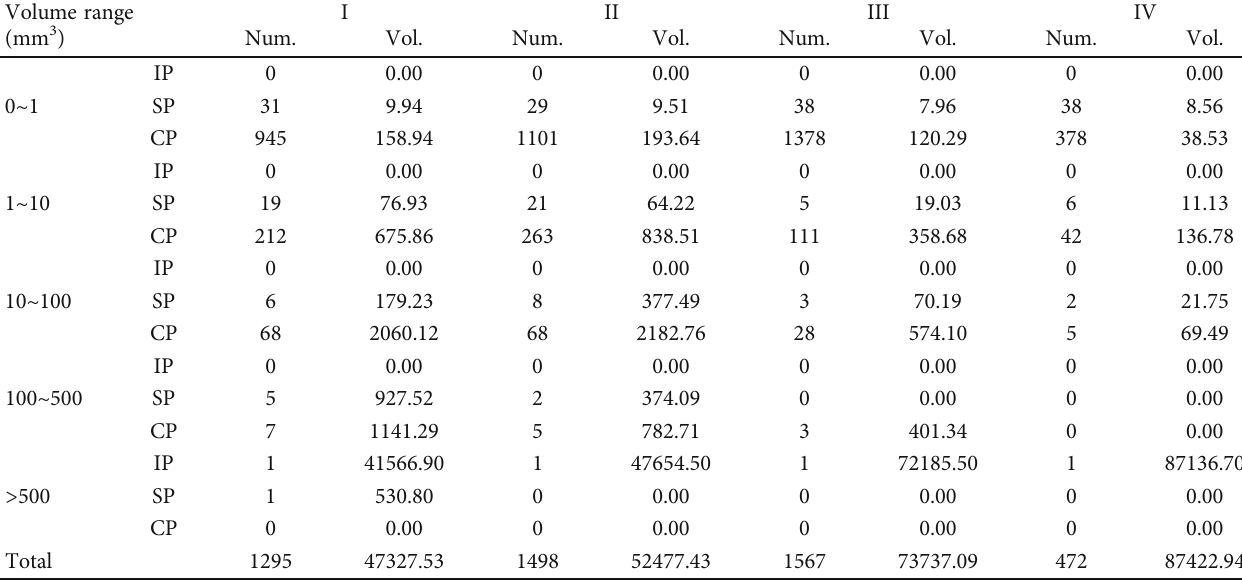
Table 2: Number and volume distribution of pore